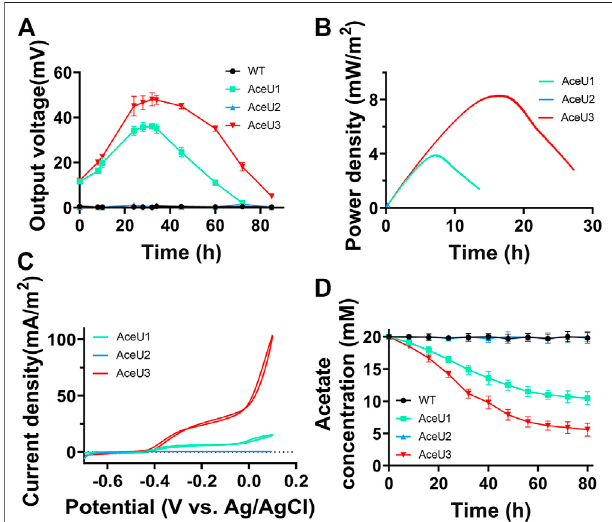
FIGURE 2 | Growth curves and acetate consumption of the WT and the recombinant S. oneidensis strains under aerobic or anaerobic conditions. (A) Aerobic growth curve (OD 600 ∼ t ) in SBM supplemented with 10 mM acetate. (B) Acetateconsumptionunderaerobiccondition. (C) Anaerobicgrowth curve (OD 600 ∼ t ) in SBM supplemented with 10 mM acetate. (D) Acetate consumption under anaerobic condition. The error bars were calculated from triplicate experiments.